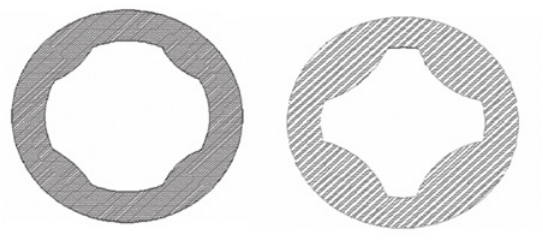
Fig. 2. Rose petal grain configuration (proposed) and star grain configuration